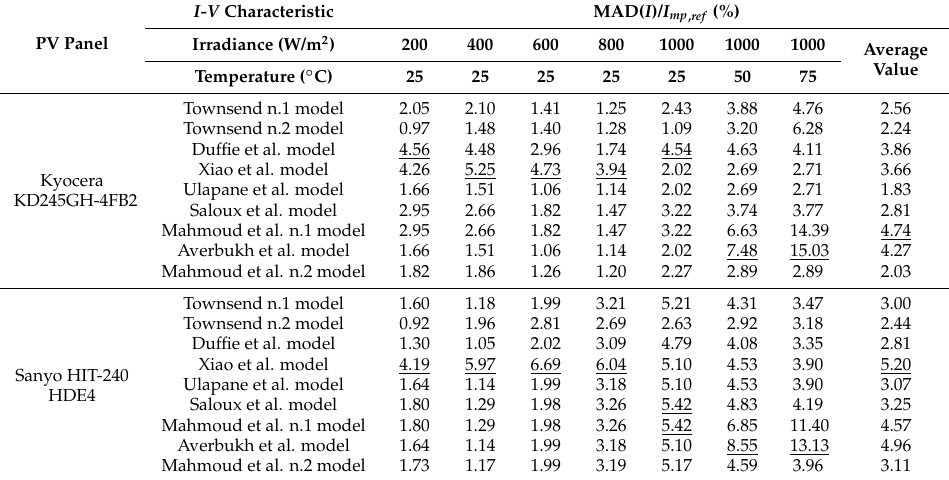
Table 5. Percentage ratio of MAD( I ) to the rated current at the MPP.